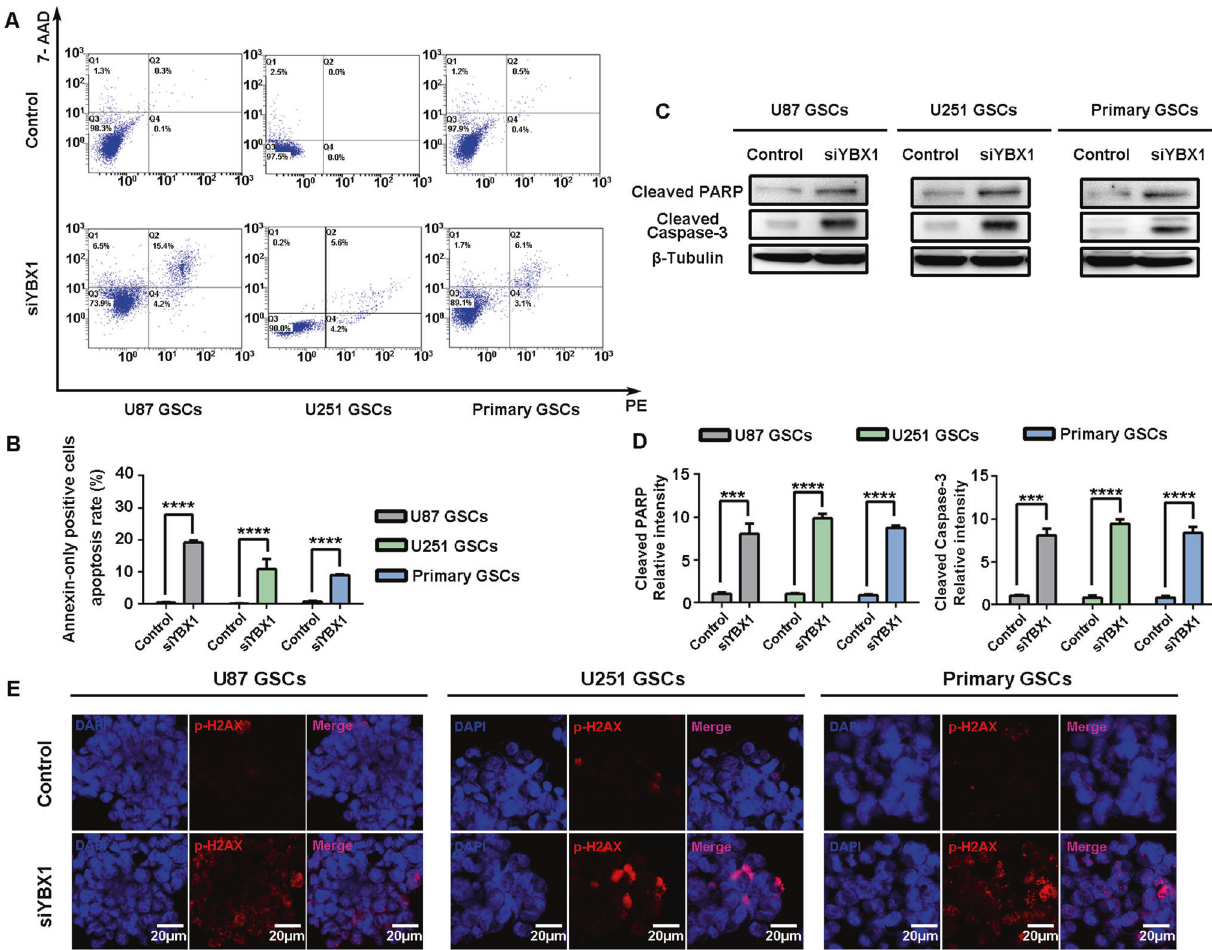
Fig. 7 YBX1 knockdown inducing apoptosis and DNA damage of GSCs. U87, U251, and primary GSCs were treated with siYBX1 knockdown. A Flow cytometry assay showed the apoptosis of GSCs. B Statistics of annexin-only positive GSCs apoptosis rate. C , D Expression of cleaved PARP and cleaved Caspase-3 were detected by Western blot. E, Cells were immunostained for γ -H2AX (red) and DAPI (blue). Scale bar = 20 μ m. Data in B and D are shown as means ± SD, n = 3, # P = NS, * P < 0.5,** P < 0.1, *** P < 0.001, **** P < 0.0001, Student ’ s t